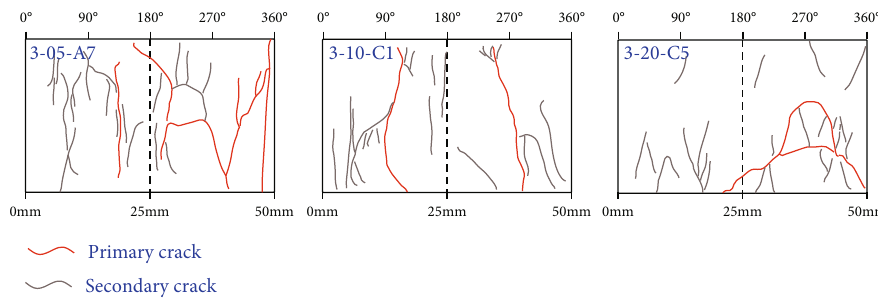
Figure 11: Sketch of fractures after failure of Scheme 3 under di ff erent con fi ning pressures.